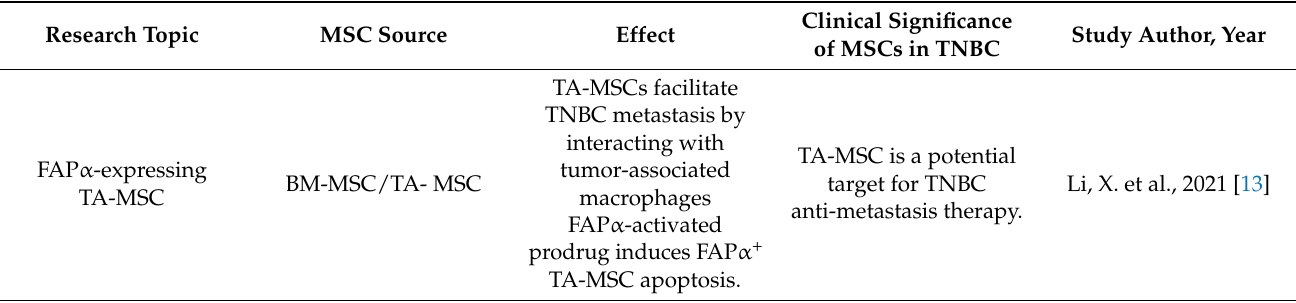
Table 1. Recent studies on the role of mesenchymal stem cells (MSCs) in the treatment of triple- negative breast cancer